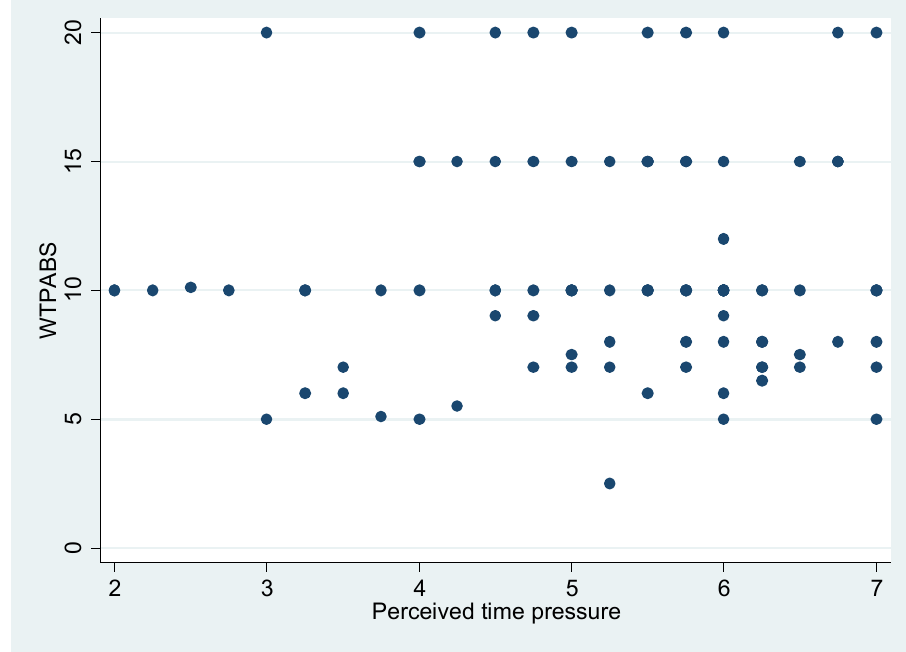
Figure 4. PTP vs. WTPABS (users only).